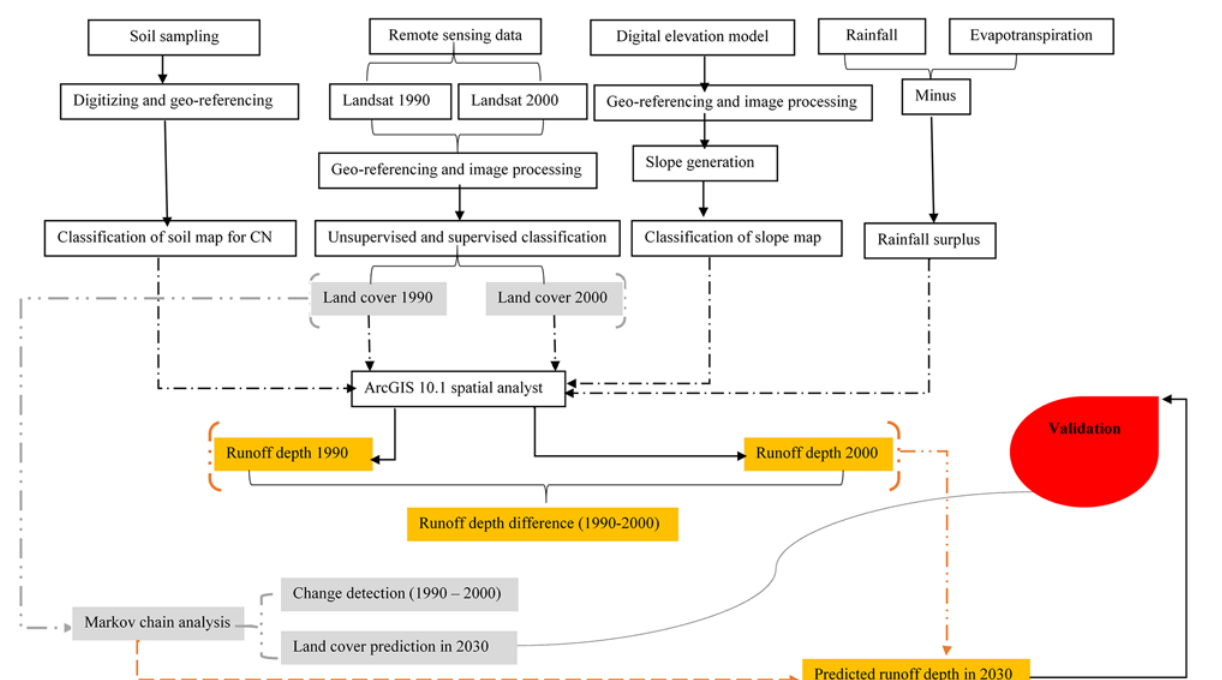
Fig 2. Workflow chart for estimating hydrological response to land cover